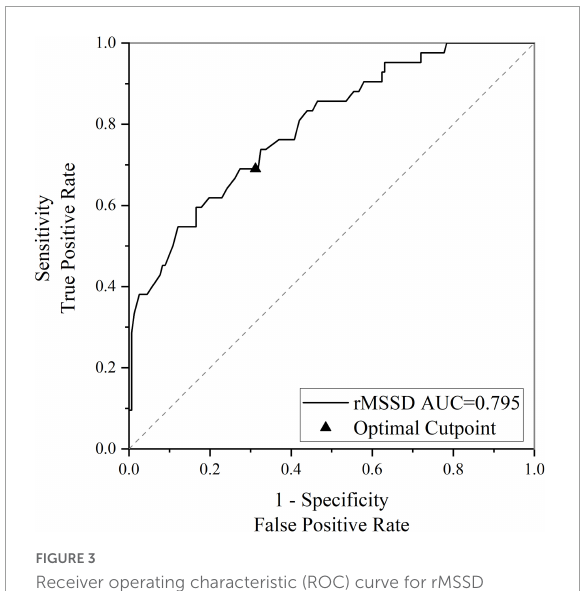
FIGURE3 Receiver operating characteristic (ROC) curve for rMSSD predicting cognitive impairment in enlarged perivascular space (EPVS) patients. rMSSD, the root mean square of successive differences of normal-normal intervals for period of interest; AUC, area under the